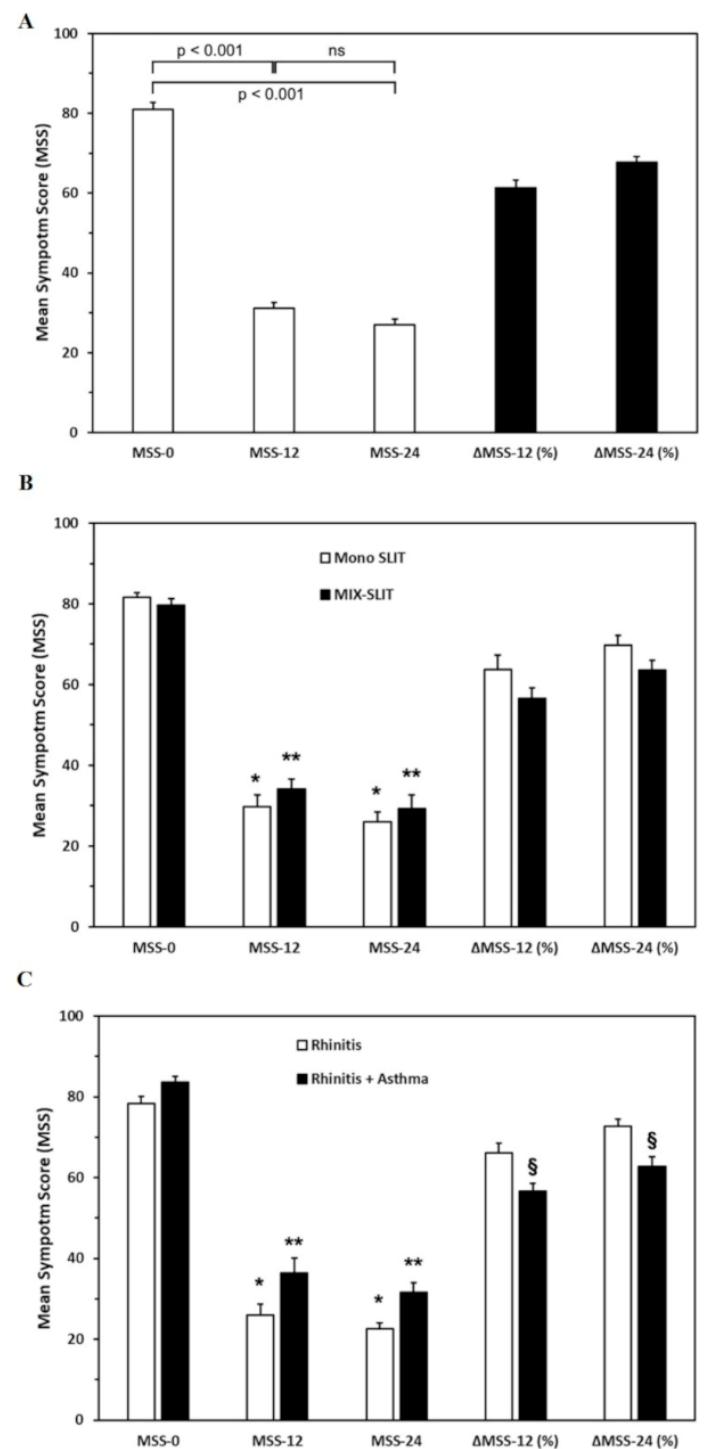
Figure 1. Sublingual immunotherapy (SLIT) efficacy assessment in the whole cohort ( A ), in patients treated with single-allergen (Mono SLIT) and two-allergen SLIT (MIX-SLIT) ( B ), and with allergic rhinitis and concomitant asthma ( C ). MSS-0: mean symptom score at T0; MSS-12: mean symptom score at T12; MSS-24: mean symptom score at T24; ∆ MSS-12 (%): percentage difference between the MSS-0 and MSS-12; ∆ MSS-24 (%): percentage difference between MSS-0 and MSS-24; ns: not significant; *,**: p < 0.001; §: p < 0.05.